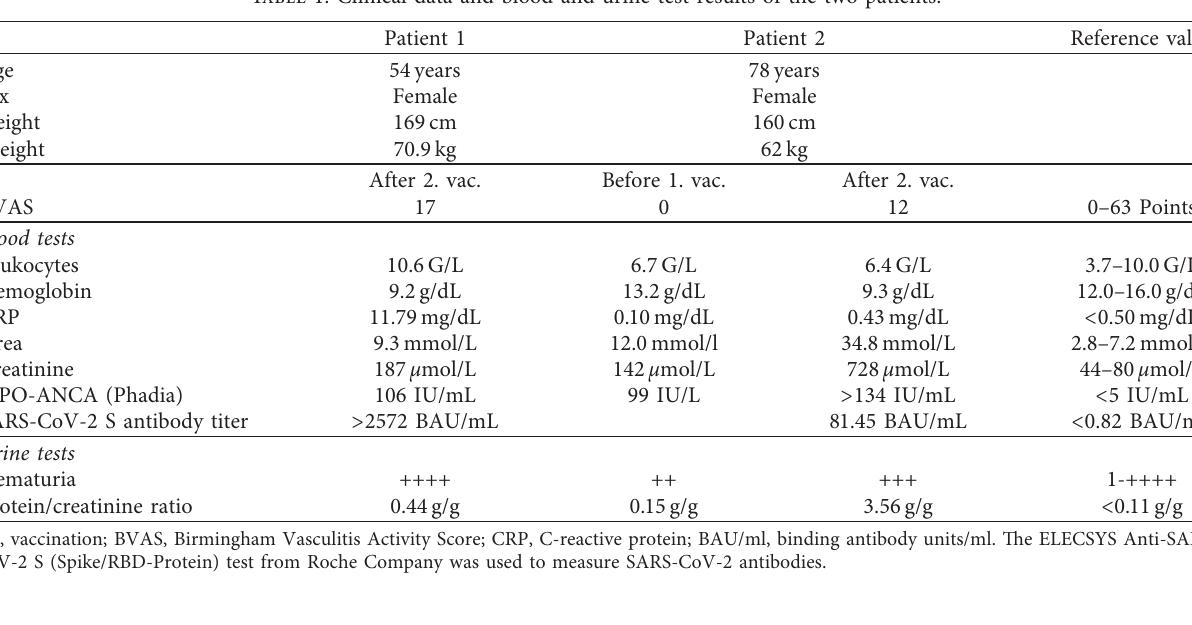
Table 1: Clinical data and blood and urine test results of the two